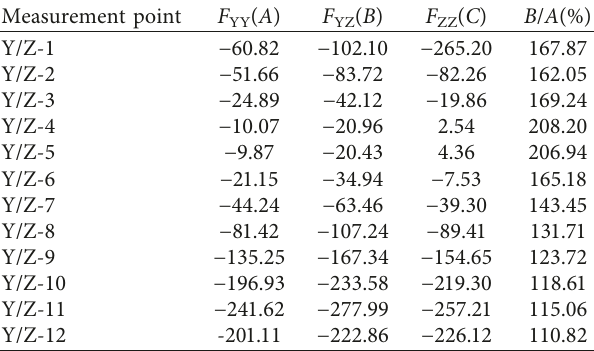
Figure 18: Axial force of initial support of tunnel: (a) right tunnel; (b) left tunnel. Table 6: Axial forces of initial supports of left and right tunnel tubes (kN).